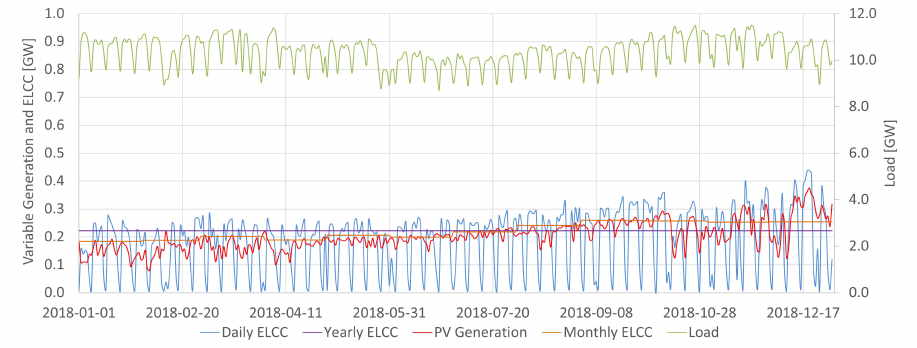
Figure 16. Daily, monthly and yearly ELCC for PV power in 2018 for the Northeast subsystem.